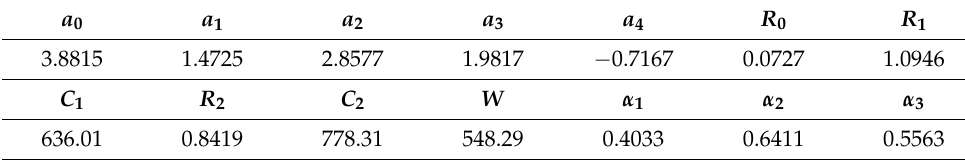
Table 2. The results of PI with the FBSO.